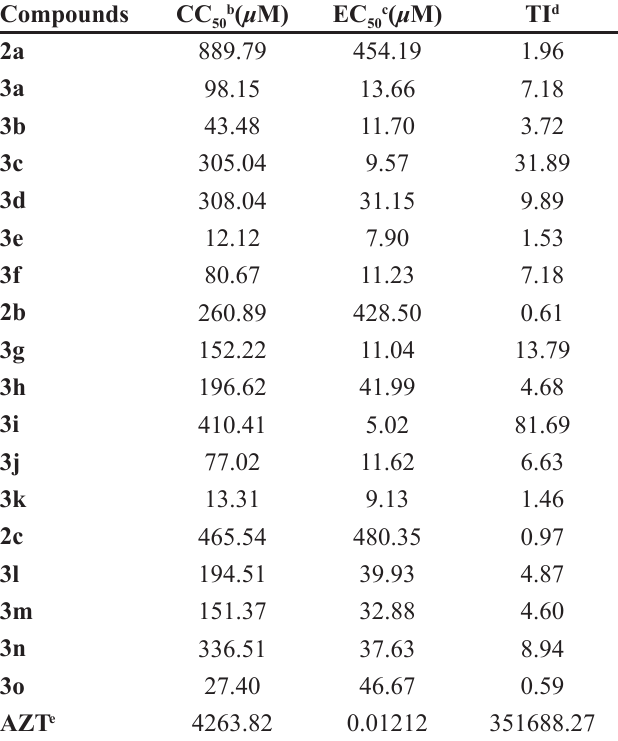
TABLE I - Anti-HIV-1 activity of n